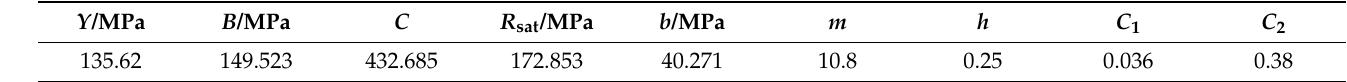
Table 2. Parameters for the revised Yoshida–Uemori hardening model of aluminum alloy